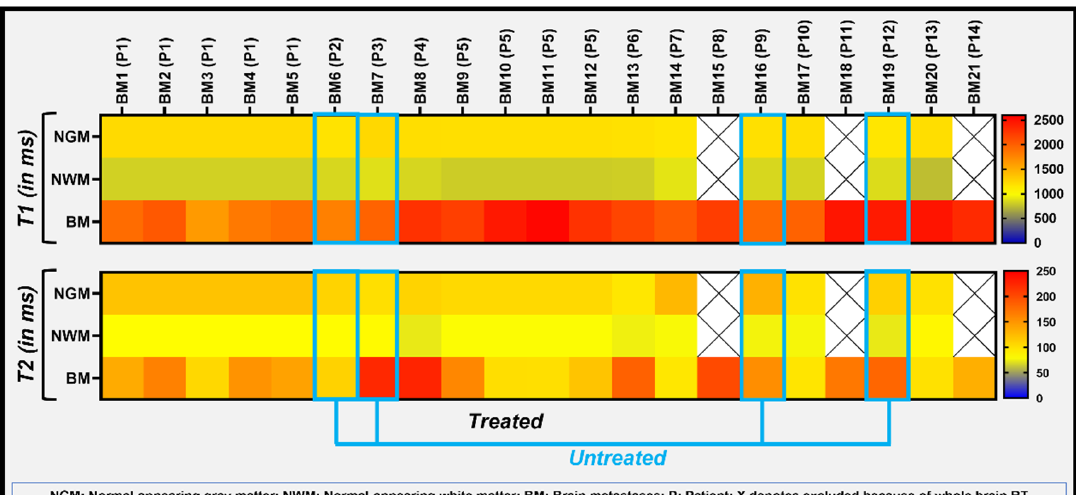
Figure 5. The heatmap exhibits the T1 and T2 metric values of all BM lesions as well as normal- appearing GM and WM. All 21 metastases from 14 patients were separately analyzed (patients were coded as “P” and metastases lesion as “BM”) and two patients (P1 and P5) had more than one metastasis (5 and 4 BM, respectively).